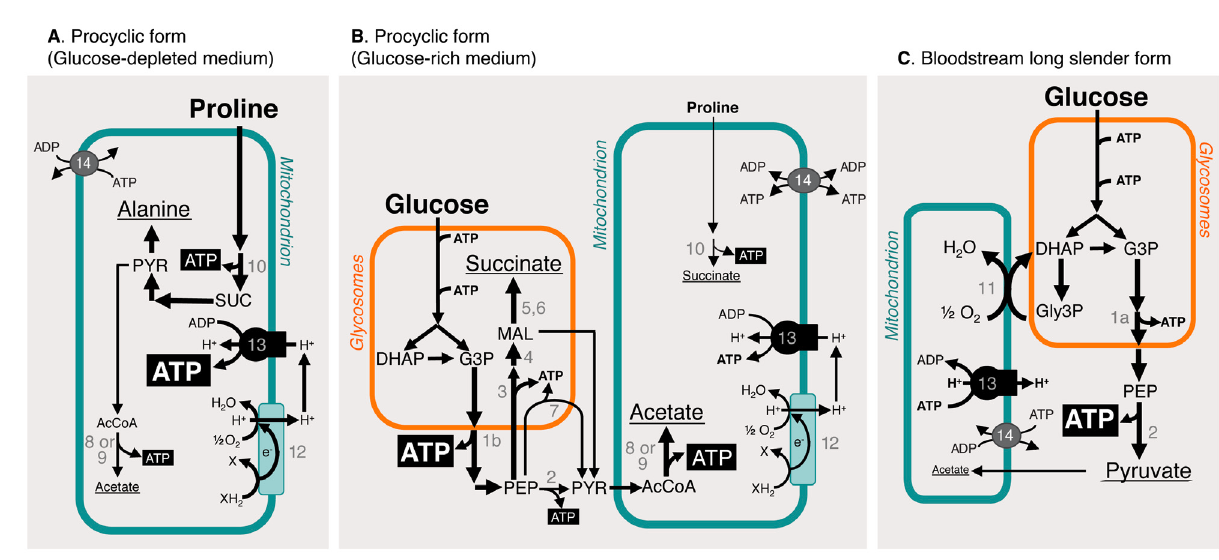
Figure 2. Multiple pathways to produce ATP in trypanosomes. Catabolism of the most abundant carbon sources in procyclic form grown in glucose-depleted ( A ) or in glucose-containing ( B ) conditions and in bloodstream long slender form ( C ). Excreted end-products from glucose and proline degradation (pyruvate, acetate, succinate and alanine) are underlined. Arrows with different thicknesses tentatively represent the metabolic flux at each enzymatic step. In ( B ), the direction of ADP/ATP exchange between the cytosol and the mitochondrion (step 14) is unknown and is represented by double arrows. Key enzymatic steps: 1a, glycosomal phosphoglycerate kinase; 1b, cytosolic phosphoglycerate kinase; 2, pyruvate kinase; 3, phosphoenolpyruvate carboxykinase; 4, glycosomal malate dehydrogenase; 5, cytosolic fumarase (for simplification this reaction is placed in the glycosome); 6, glycosomal NADH-dependent fumarate reductase; 7, pyruvate phosphate dikinase; 8, acetate:succinate coenzyme A-transferase, or ASCT; 9, acetyl-coenzyme A thioesterase; 10, succinyl-coenzyme A synthetase; 11, trypanosome alternative oxidase; 12, respiratory chain; 13, F F -ATP synthase; 14, mitochondrial ADP/ATP exchanger. 0 1 AcCoA, acetyl-coenzyme A; DHAP, dihydroxyacetone phosphate; G3P, glyceraldehyde 3-phosphate; Gly3P, glycerol 3-phosphate; MAL, malate; PEP, phosphoenolpyruvate; PYR, pyruvate; SUC,